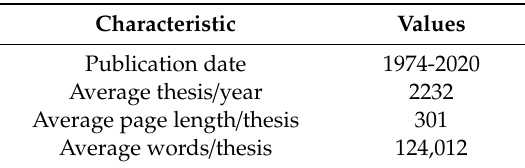
Table 3. Relevant